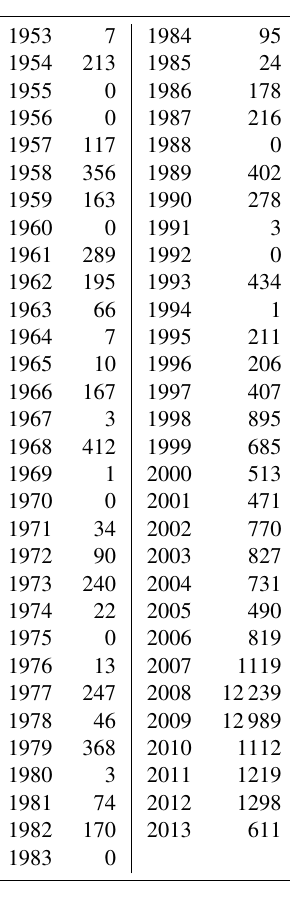
Table A1. Yearly values of the Barnett Severity Index (BSI). Source: Rebecca Rolph, Geophysical Institute, University of Alaska,